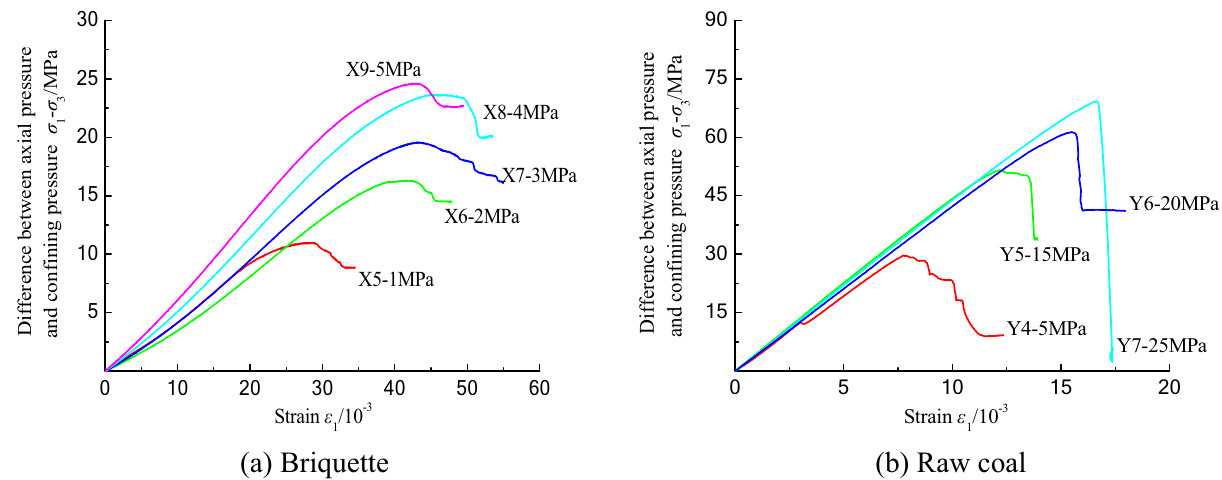
Figure 6. Stress–strain curves of coal samples under uniaxial